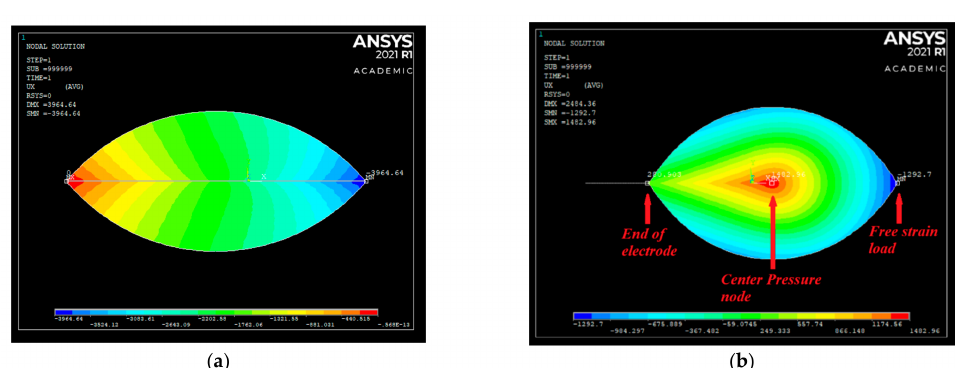
Figure 22. (Above) ( a ) Sliding mechanism post-FEM analysis contour plot of the displacement of the structure ‘x’ direction from the highest displacement in the positive direction (in red) and the highest displacement in the negative direction (displayed in µ m). ( b ) Zipping mechanism post FEM analysis contour plot of the displacement of the structure ‘x’ direction from the highest displacement in the positive direction (in red) and the highest displacement in the negative direction (displayed in µ